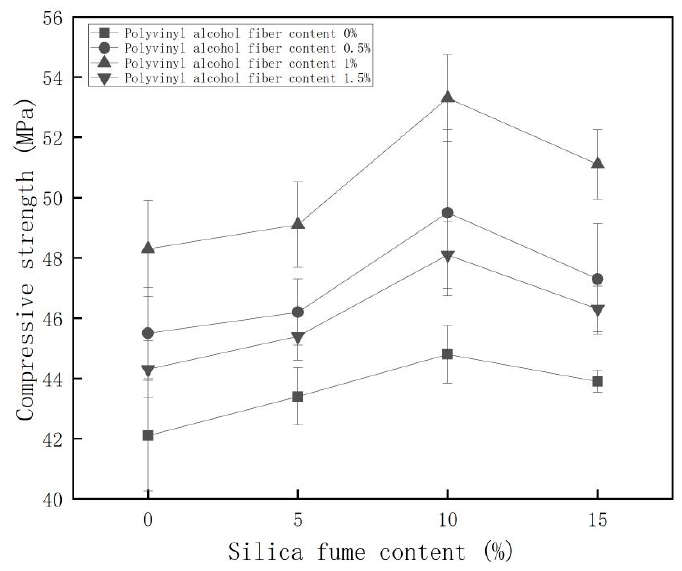
Figure 2. Change in compressive strength.